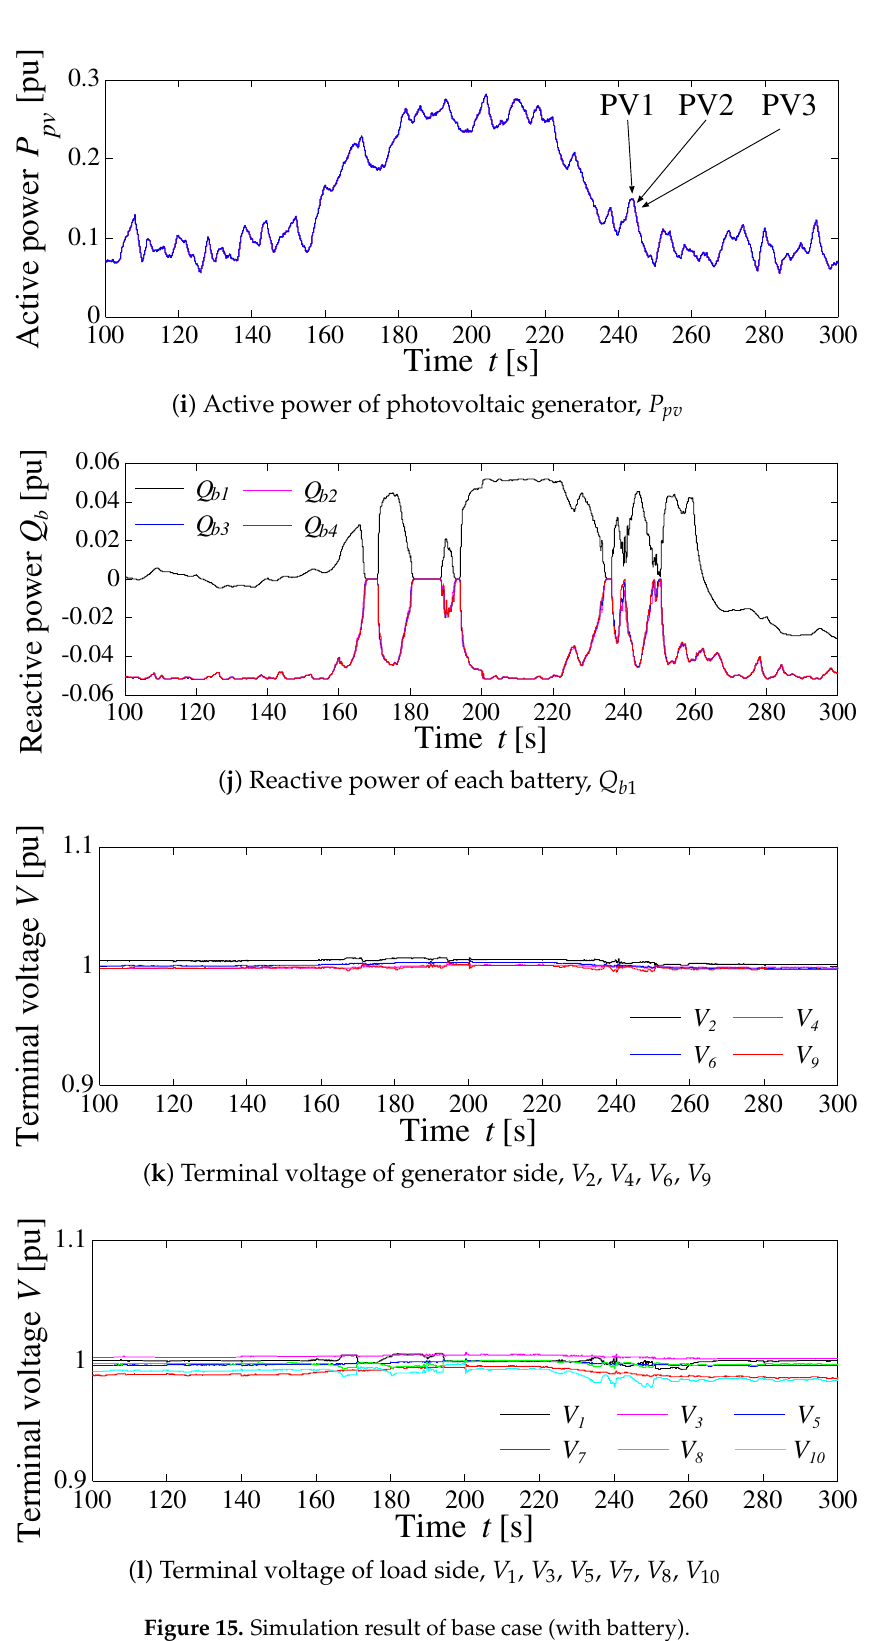
Figure 15. Simulation result of base case (with